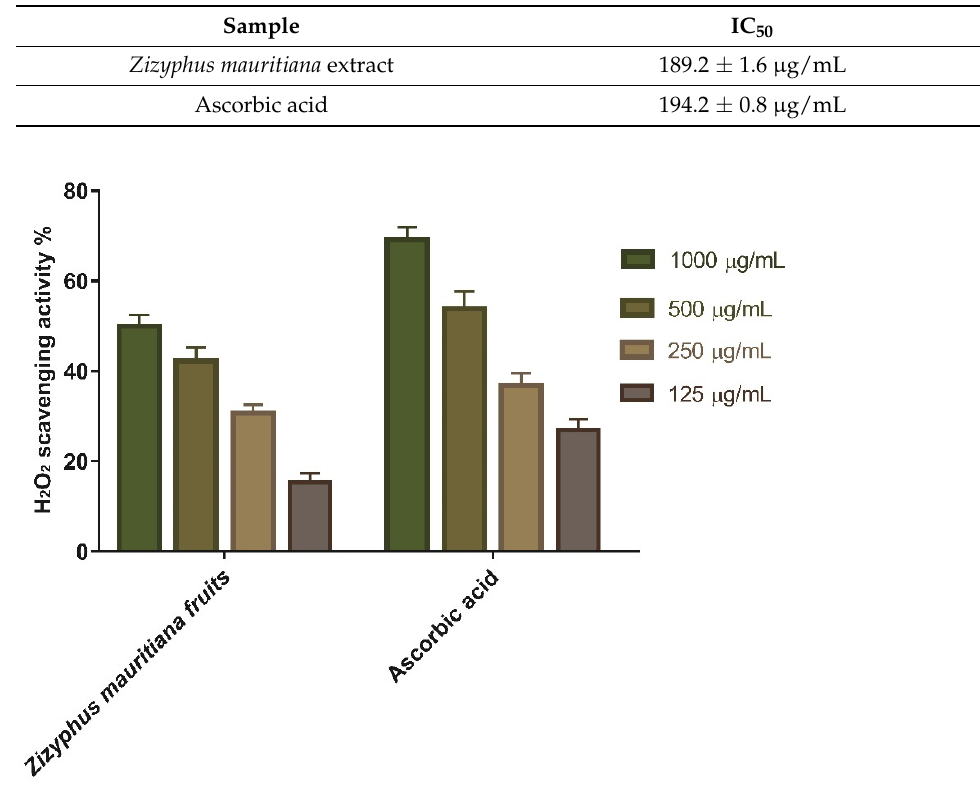
Figure 1. H 2 O 2 Radical scavenging activity of Z. mauritiana fruit extract at different concentration (1000, 500, 250, and 125 µg/mL). Bars represent mean ± standard deviation (SD). The significant difference between test groups analyzed by a Two-way ANOVA test after normalization of variables by the Shapiro Wilk test.